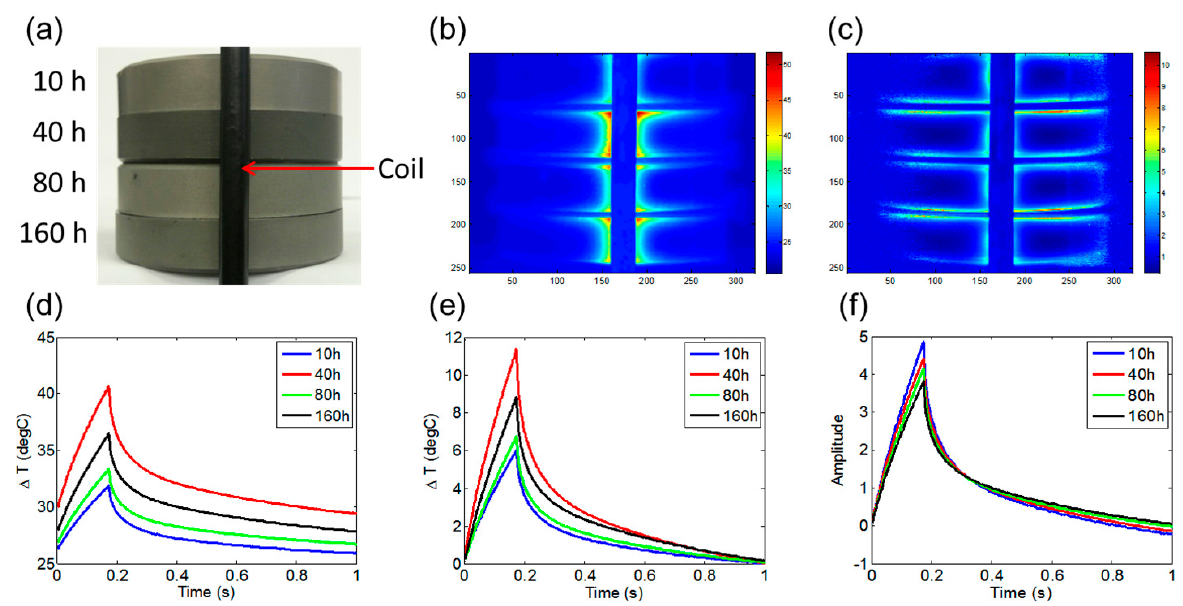
Figure 4. Images of four case-nitrided gear steels: ( a ) Sample photograph. ( b ) Original IR image at the maximum heating time. ( c ) Thermal pattern after emissivity correction. ( d ) Original transient temperature responses. ( e ) Post first frame subtraction. ( f ) Emissivity-adjusted transient thermal re- sponses.